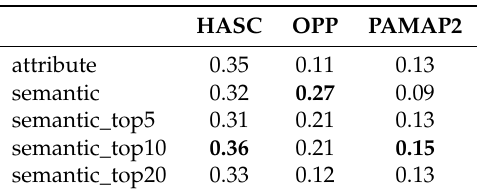
Table 7. Average F-score of the estimation of activity classes with 3 datasets. For each dataset we show the 5 methods using different semantic